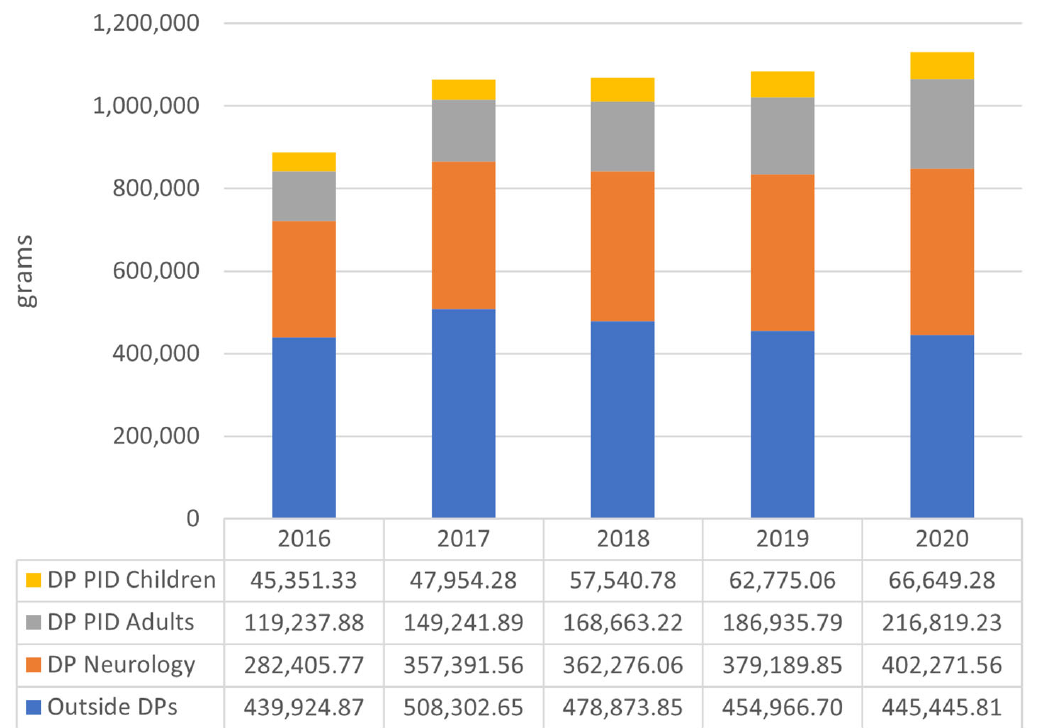
Figure 2. Immunoglobulin use (in grams) reported annually in Poland divided into drug programs and other indications. DP: drug program; PID: primary immunodeficiency. DPs: drug programs.